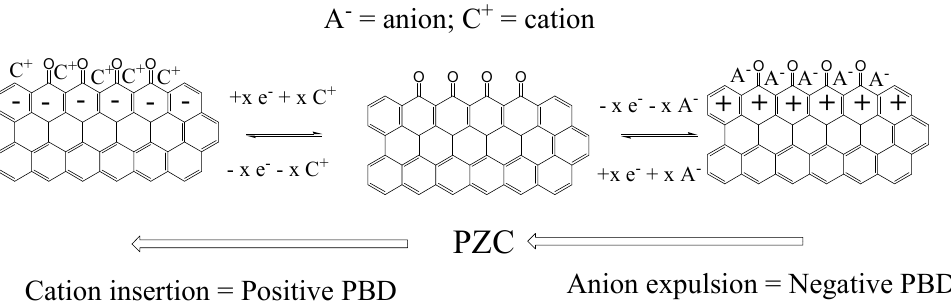
Scheme 4. Ion exchange during charging/discharging of the double layer on the carbon